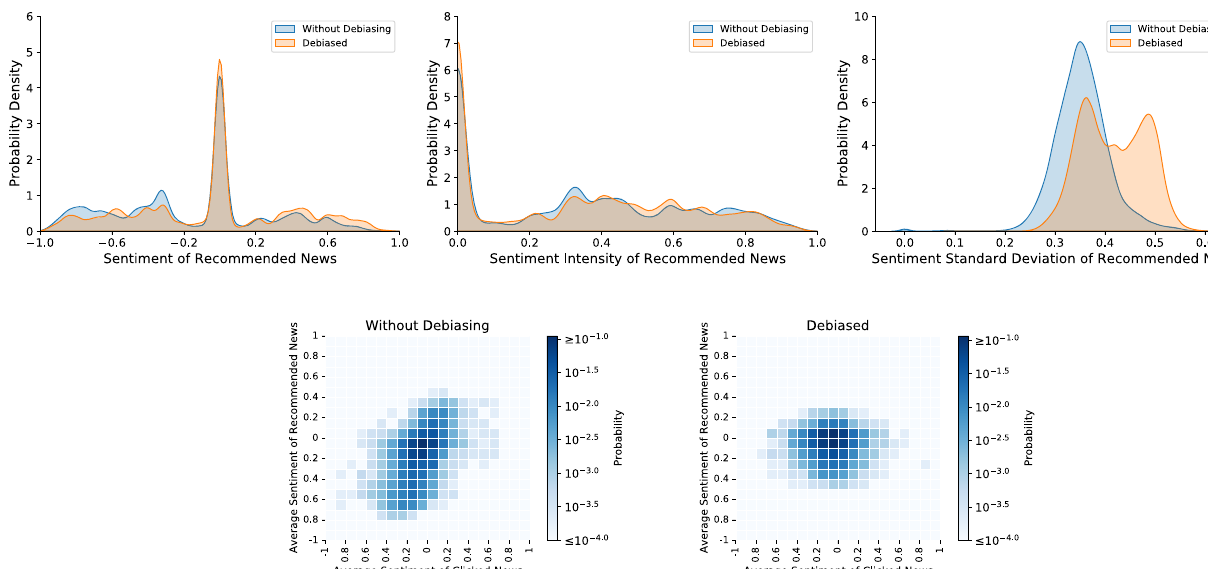
Fig. 5 Impact of sentiment debiasing on the sentiment of recommended news. Upper: the distributions of sentiment orientation, sentiment intensity, and sentiment variance of the biased or debiased recommendation results. The left plot shows that negative news is demoted in debiased recommendation results while positive and neutral news articles are promoted. The middle plot shows the sentiment intensity of debiased recommendations is slightly weaker than biased ones ( p < 0.01). The right plot shows that the sentiment standard deviation of debiased recommendations is much larger than biased ones, indicating that our sentiment-debiasing method improves sentiment diversity. Lower: the correlations between the average sentiment of clicked news and recommended news given by biased or debiased models. Darker colors indicate higher probability densities. The left plot shows the sentiments of news recommended by biased models have signi fi cant correlations with historically clicked news ( r = 0.5109, p < 0.001). The right plot indicates that in